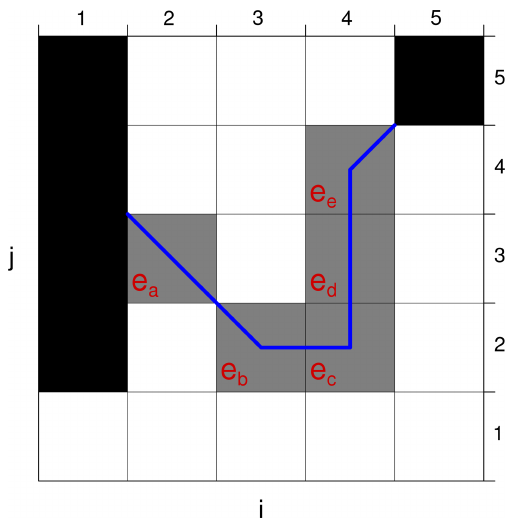
Figure 1. Schematic illustration for the computation of the ice edge length. The ice edge is displayed by the labelled cells that are filled in gray. Black cells correspond to land. The algorithm we present here for calculation of the ice edge length yields a value that corre- sponds to the length of the blue line; see the text for